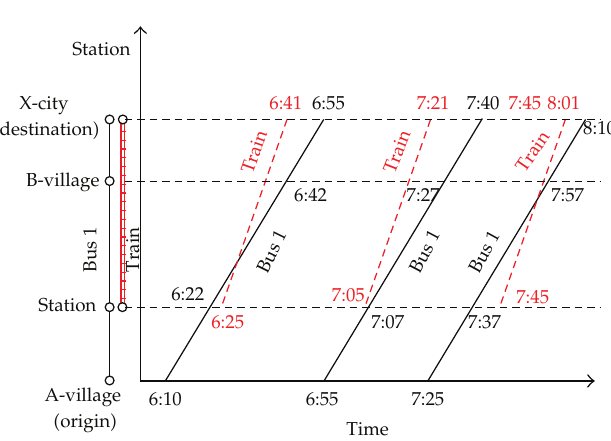
Figure 1: An example schedule-based transit network (cid:2) Friedrich and Wekeck (cid:5) 19 (cid:6)(cid:3) .